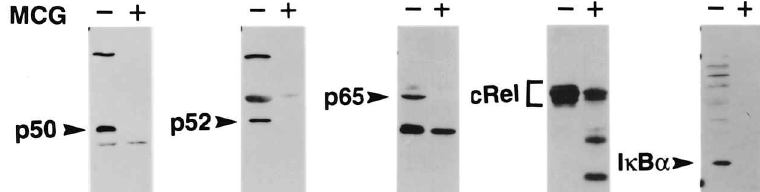
FIG. 8. Western analysis of the effect of MCG on NF- k B/I k B a in the isolated cytosolic fraction. The cytosol fractions prepared from J774 cells were incubated without (–) or with MCG (+) for 1h at 37°C at J774 cell to mast cell equivalent ratio of 5 to 1. At the end of the incubation period, they were subjected to Western analysis using anti-N-terminal peptides of p50, p52, p65, c-Rel or I k B a